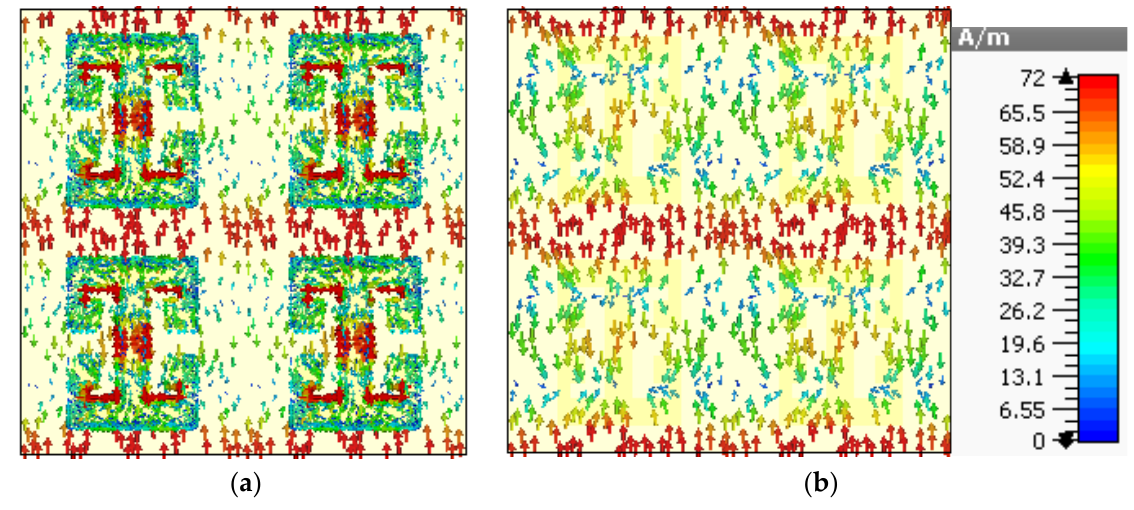
Figure 5. Surface current density for 24.7 GHz ( a ) top metasurface and ( b ) bottom surface.